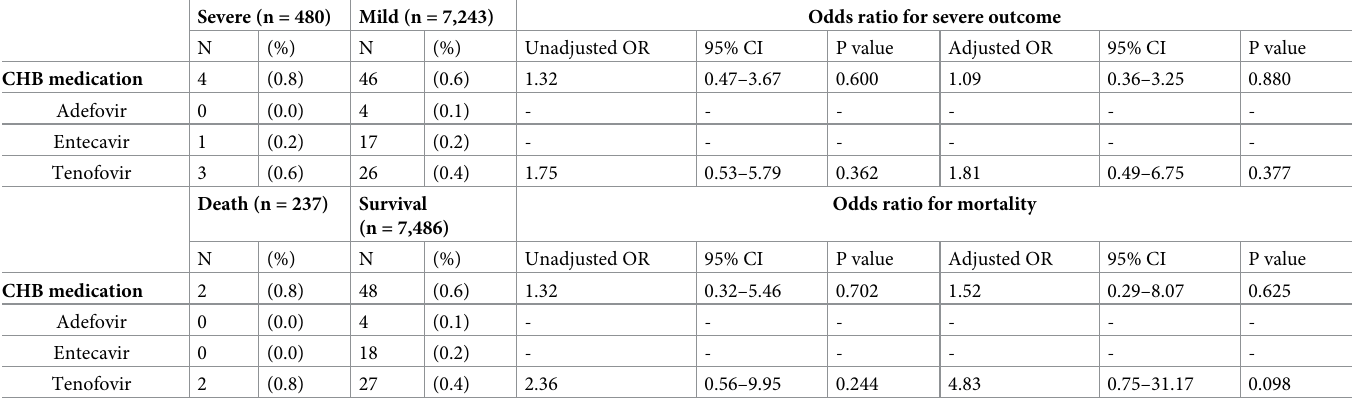
� p-value by multiple logistic regression model. Abbreviations: CHB, chronic hepatitis B; CI, confidence interval; OR, odds